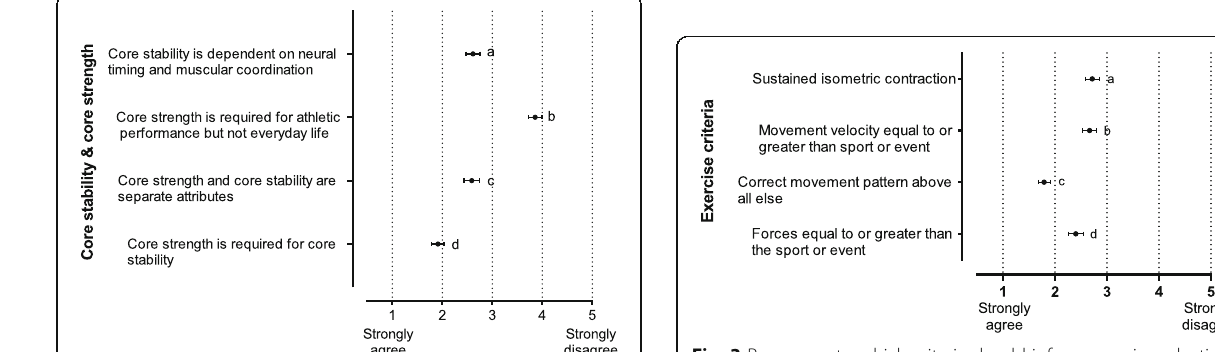
Fig. 3 Responses to which criteria should inform exercise selection for the development of core stability for dynamic athletic performance. Data are reported as mean level of agreement with 95% CI. 1 = strongly agree, 5 = strongly disagree. Significant differences p < 0.05: a vs c, a vs d, b vs c, b vs d and c vs d. CI: confidence